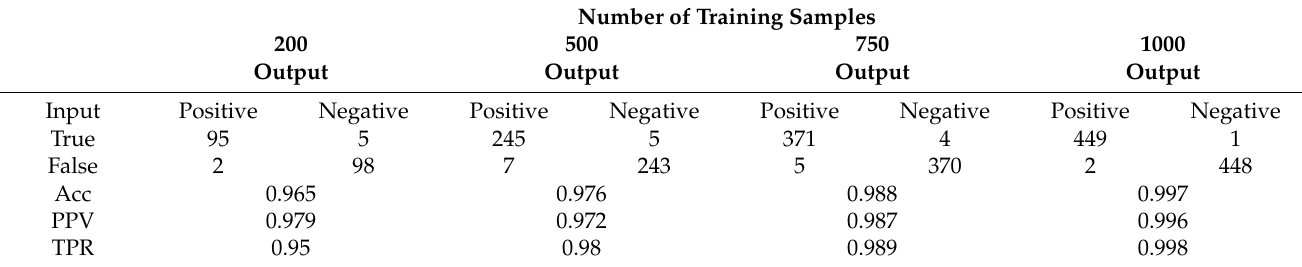
Table 1. Confusion matrix.